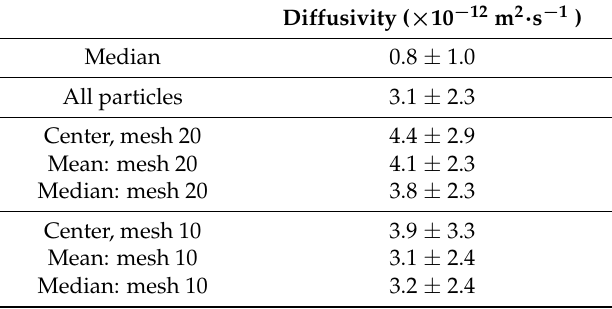
Table 1. Water vapor diffusivity for different shape descriptors and